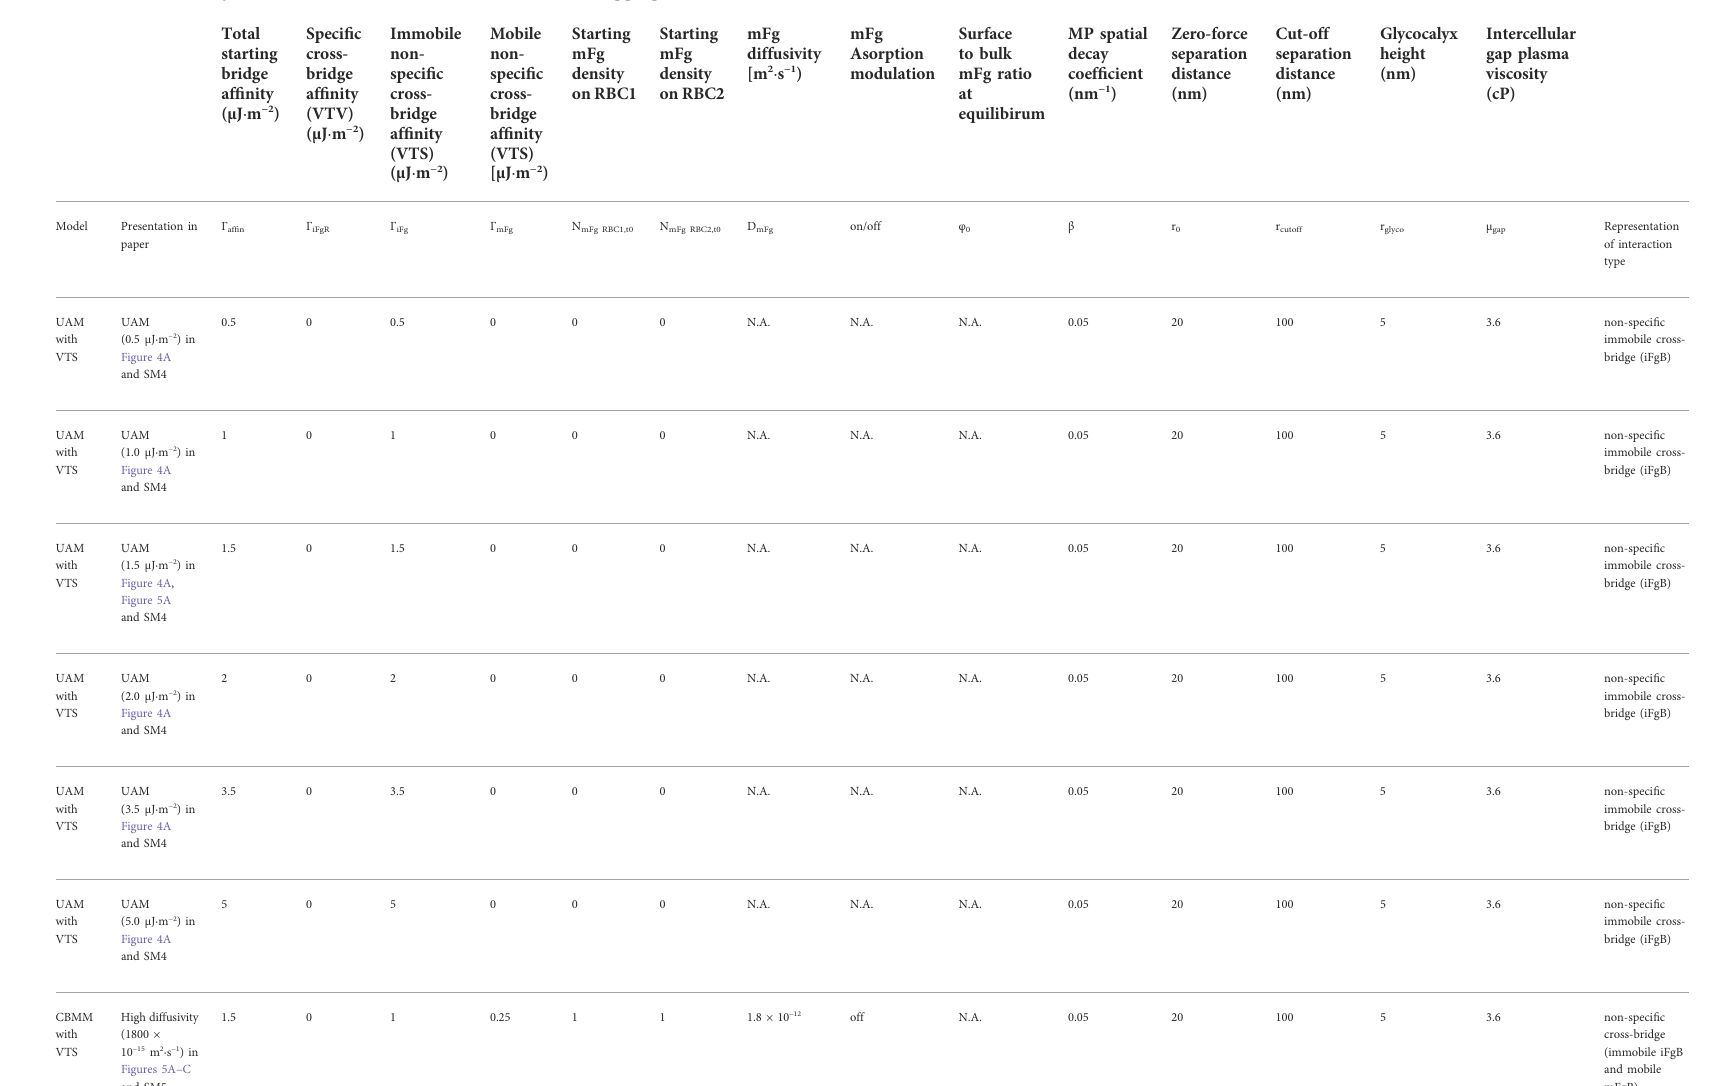
TABLE 3 Simulation parameters for CBMM and UAM in doublet disaggregation